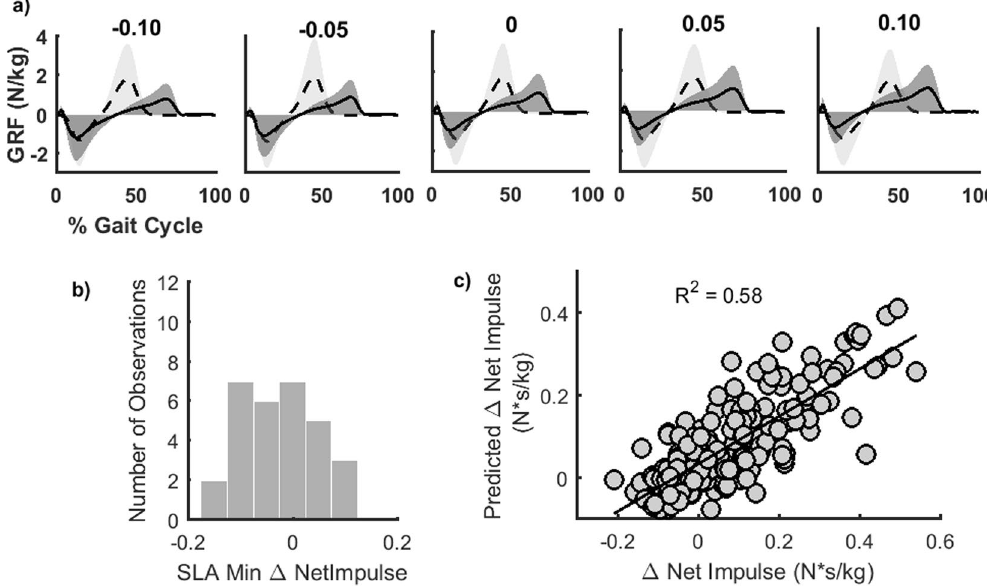
Figure 4. Associations between braking and propulsive impulses and asymmetry. ( a ) Fore-aft ground reaction forces for each achieved step length asymmetry for the fast (dashed) and slow (solid) leg. Data are pooled by achieved asymmetry, not by target asymmetry. The braking impulse was defined as the area under the negative portion of the leading limb’s fore-aft ground reaction curve during the first half of the gait cycle. Similarly, the propulsive impulse was computed as the area under the curve for the positive portion of the trailing limb’s fore-aft ground reaction force in the second half of the gait cycle. ( b ) Histogram of step length asymmetries associated with the minimum net impulse. ( c ) Plot of measured vs. predicted net impulses using the linear mixed effects model defined in Equation